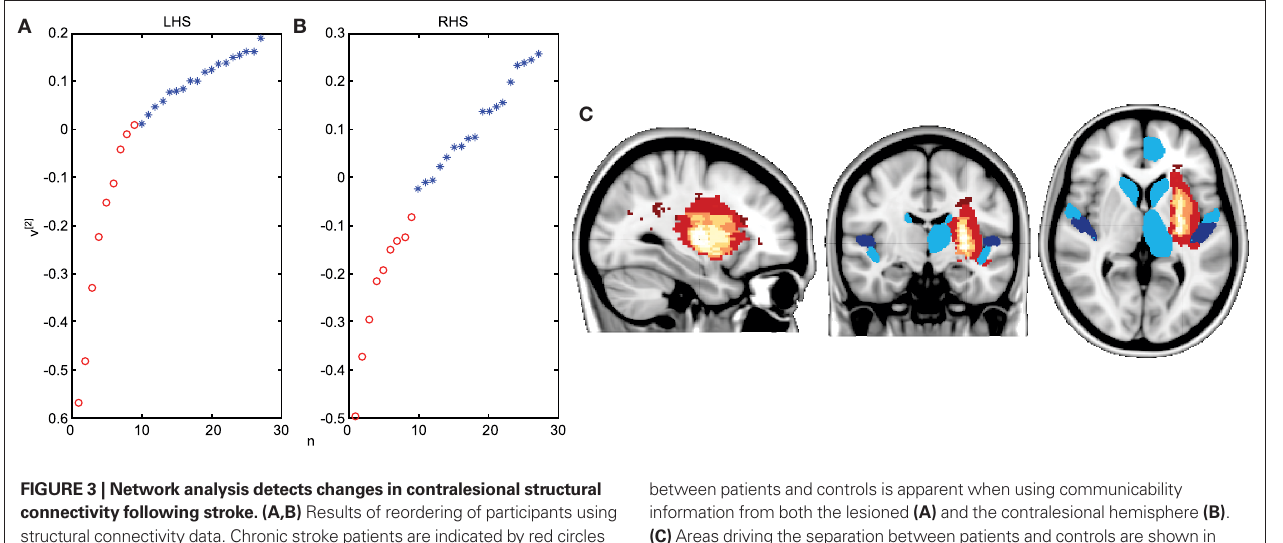
FIguRe 3 | Network analysis detects changes in contralesional structural connectivity following stroke. (A,B) Results of reordering of participants using structural connectivity data. Chronic stroke patients are indicated by red circles and age-matched healthy controls by blue stars. Ordering of participants is achieved using spectral reordering and is based on the right singular vector, v[2], which is plotted on the y -axis (see Crofts et al., 2010 for details). Individuals are ordered along the x -axis based on increasing values of [v]2. Clear separation